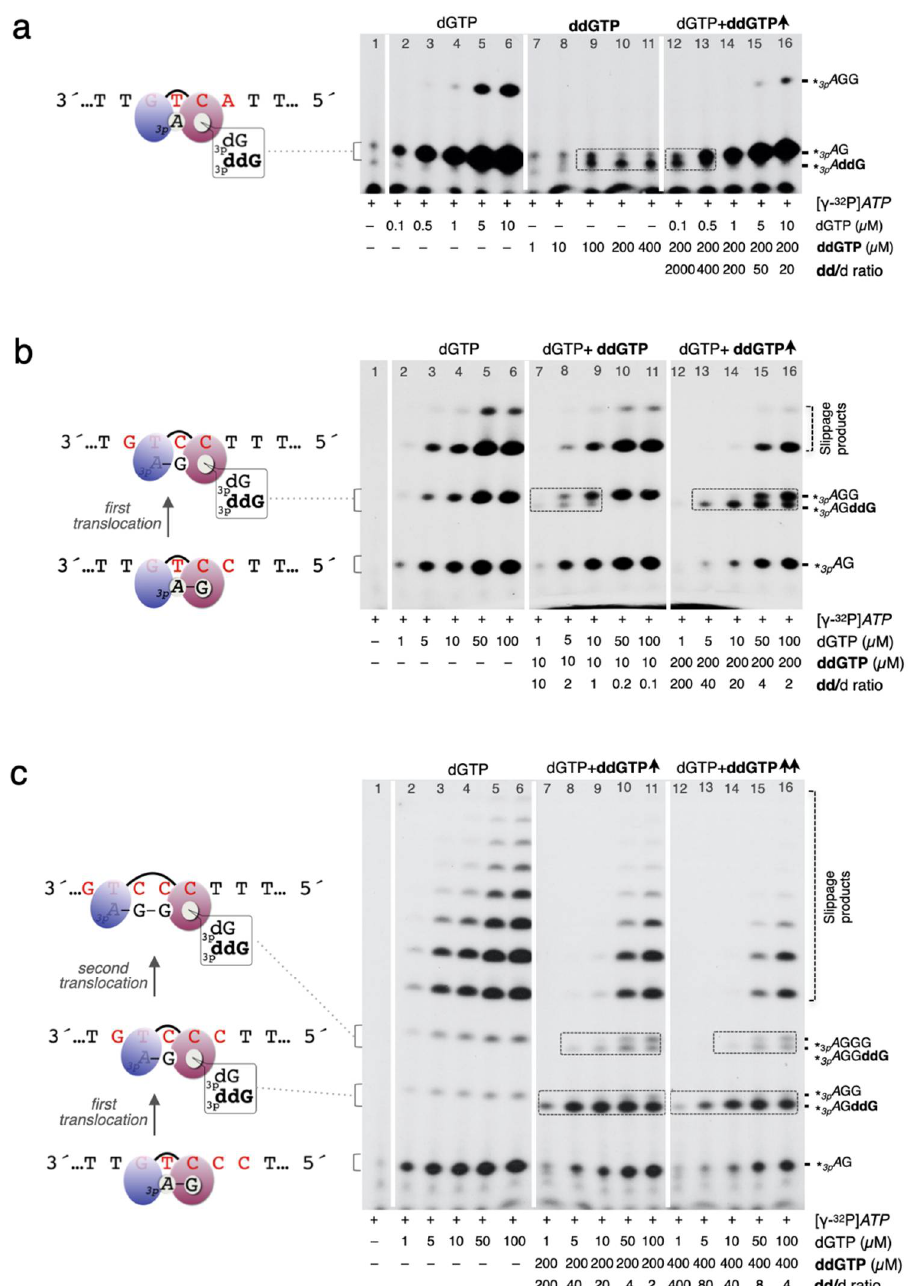
Figure 3. PrimPol shows a strong discrimination against ddNTPs during initiation of primer synthesis. ( a ) Dimer formation: PrimPol strongly discriminates against ddNTPs when making the initiating dimer. The left panel shows conventional 3p A dG primer formation on the GTCA template. The middle panel shows how inefficient the reaction is when natural